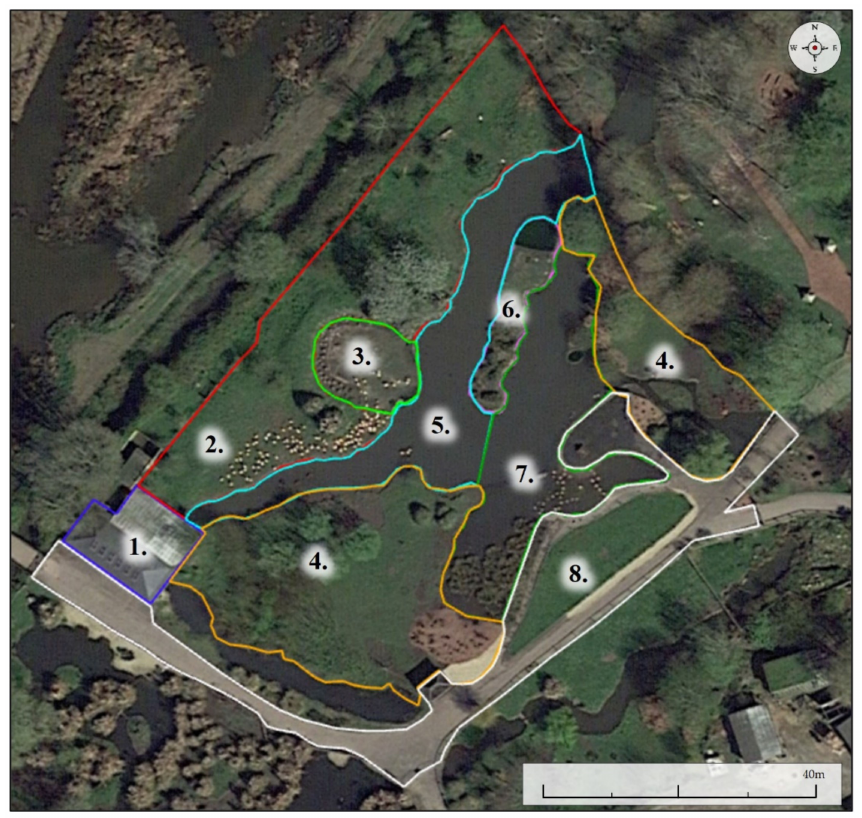
Figure 2. ‘South America’ walk through enclosure at WWT Slimbridge split into zones for analysis. 1/purple = shelter; 2/red = back grasslands; 3/green = nesting area; 4/orange = bushlands; 5/blue = mid-waters; 6/pink = island; 7/dark green = front waters; 8/white = public viewing